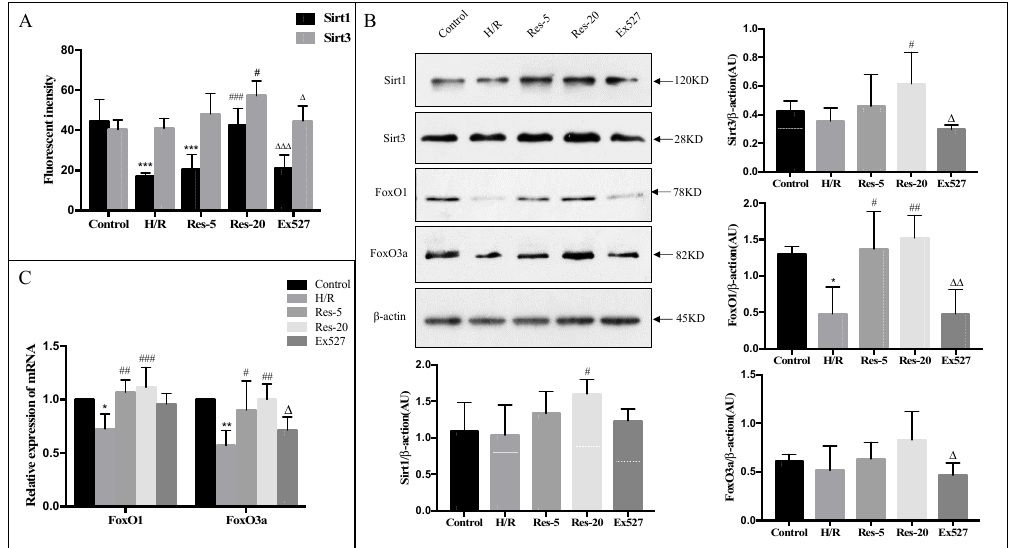
Figure 2. Resveratrol treatment increases the expression of Sirt1, Sirt3 and FoxO in neonatal rat cardiomyocytes suffering H/R, while this effect was abrogated by EX527. ( A ) Effects of resveratrol on Sirt1 and Sirt3 activities of H/R injury cardiomyocytes were measured by microplate reader. ( B ) Cardiomyocytes lysates were subjected to Western blot analysis for Sirt1, Sirt3, FoxO1 and FoxO3a. ( C ) The mRNA expression of FoxO1 and FoxO3a in cardiomyocytes was detected by Real-Time PCR. Figures are representative images of three different samples. Results are expressed as mean ± S.D. * p < 0.05, ** p < 0.01, *** p < 0.001 vs. control group; # p < 0.05, ## p < 0.01, ### p < 0.005 vs. H/R